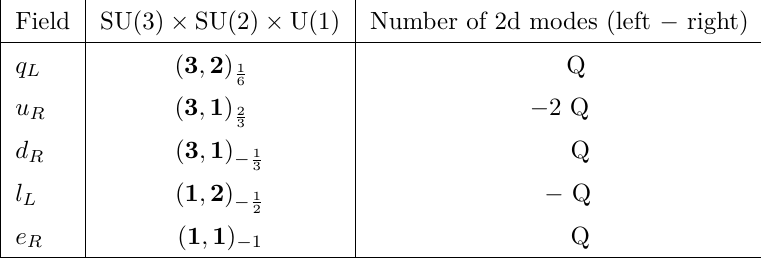
Table 1 . Total number of complex two dimensional modes from each generation. For example, for the left handed quark doublets we have Q/ 6 two dimensional leftmoving fermions in the represen- tation ( 3 , 2 ) giving a total number of Q complex fermion